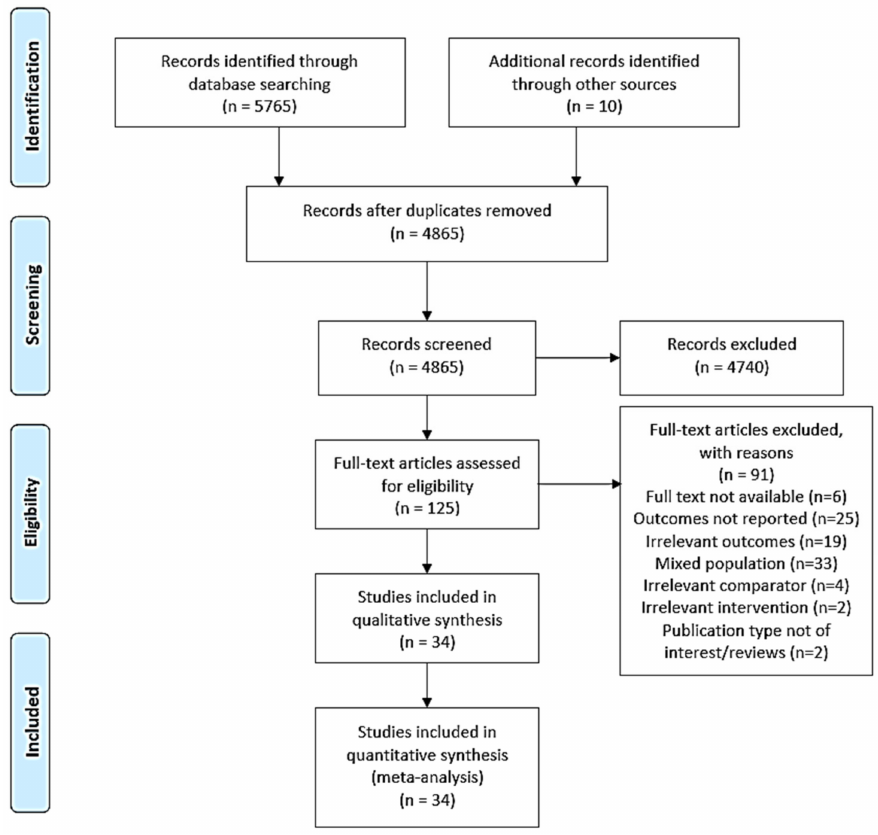
Figure 1. PRISMA flow diagram of the process for study